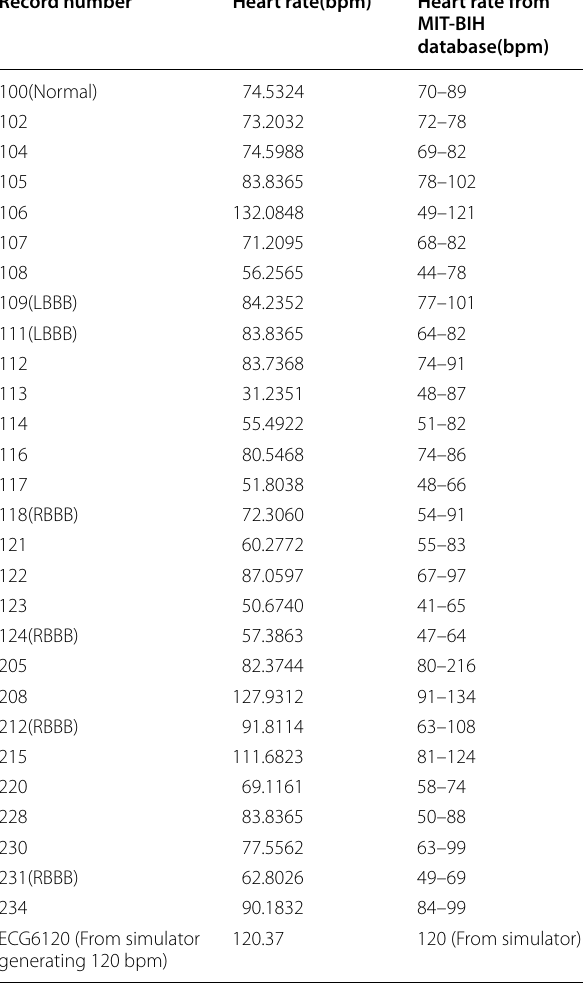
Table 1 Heart rates from the proposed method compared with